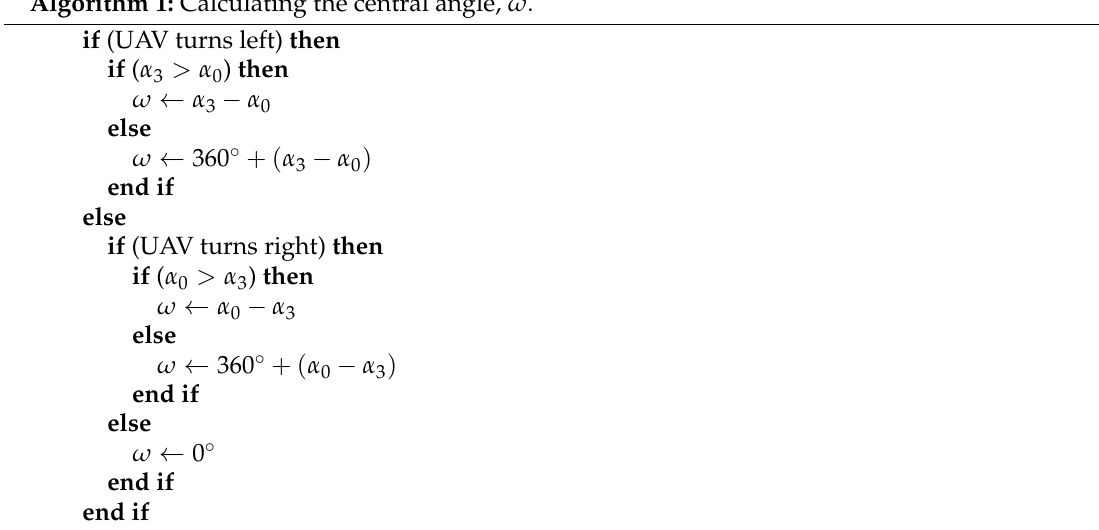
Figure 8. ( a ) UAV flies clockwise where α 0 < α 3 ; ( b ) UAV flies clockwise where α 0 > α 3 . The central angle is calculated as indicated in Algorithm 1. Algorithm 1: Calculating the central angle, ω